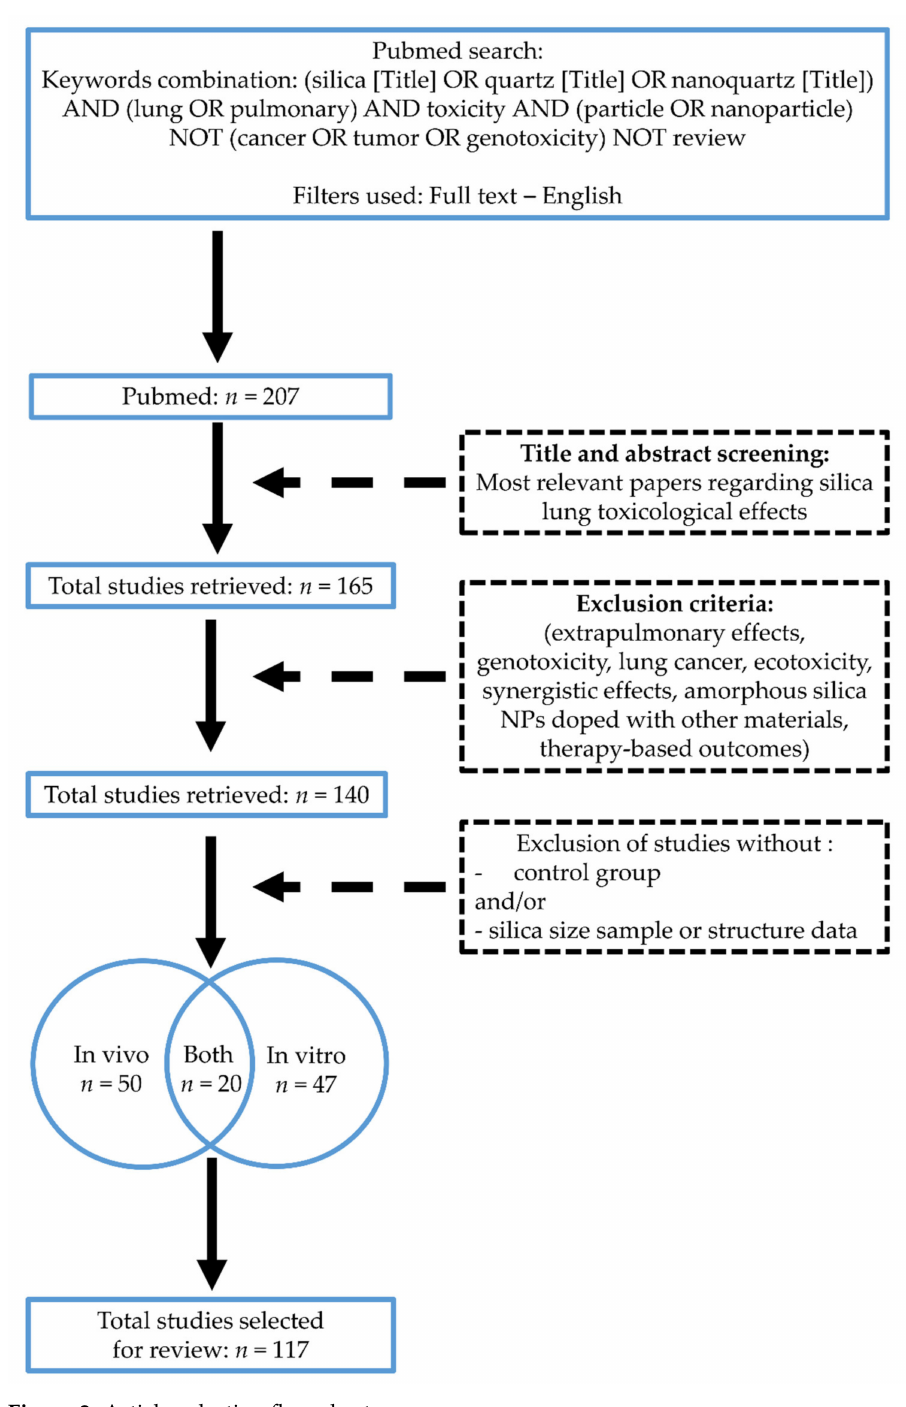
Figure 2. Article-selection flow